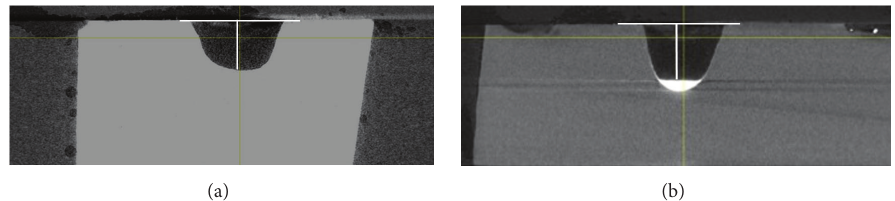
Figure 8: Samples of cavity cut by alumina ((a) with indistinguishable powder layer from dentine) and Na0SR ((b) with a very radiopaque powder layer due to the presence of